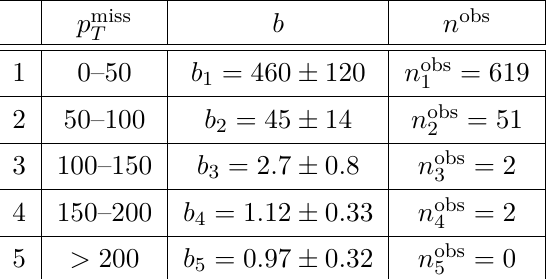
Table 3 . The number of background events ( b ) and the number of observed events ( n obs ) in each bin (taken from table 18 of ref. p miss T